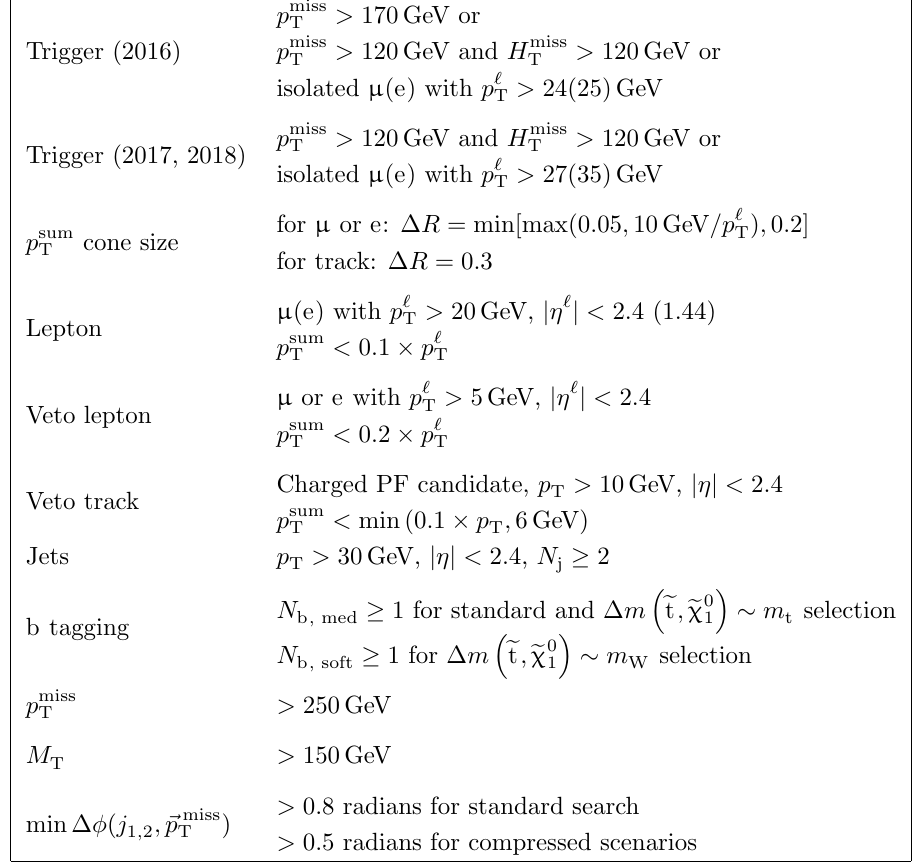
Table 1 . Summary of the event preselection requirements. The magnitude of the negative vector sum of the p of all jets and leptons in the event is denoted by H miss . The symbols p ‘ and (cid:17) ‘ T T T correspond to the transverse momentum and pseudorapidity of the lepton. The symbol p sum is the T scalar sum of the p of all (charged) PF candidates in a cone around the lepton (track), excluding T the lepton (track) itself. Finally, N and N are the multiplicity of b-tagged jets (medium b ; med b ; soft working point) and soft b objects,